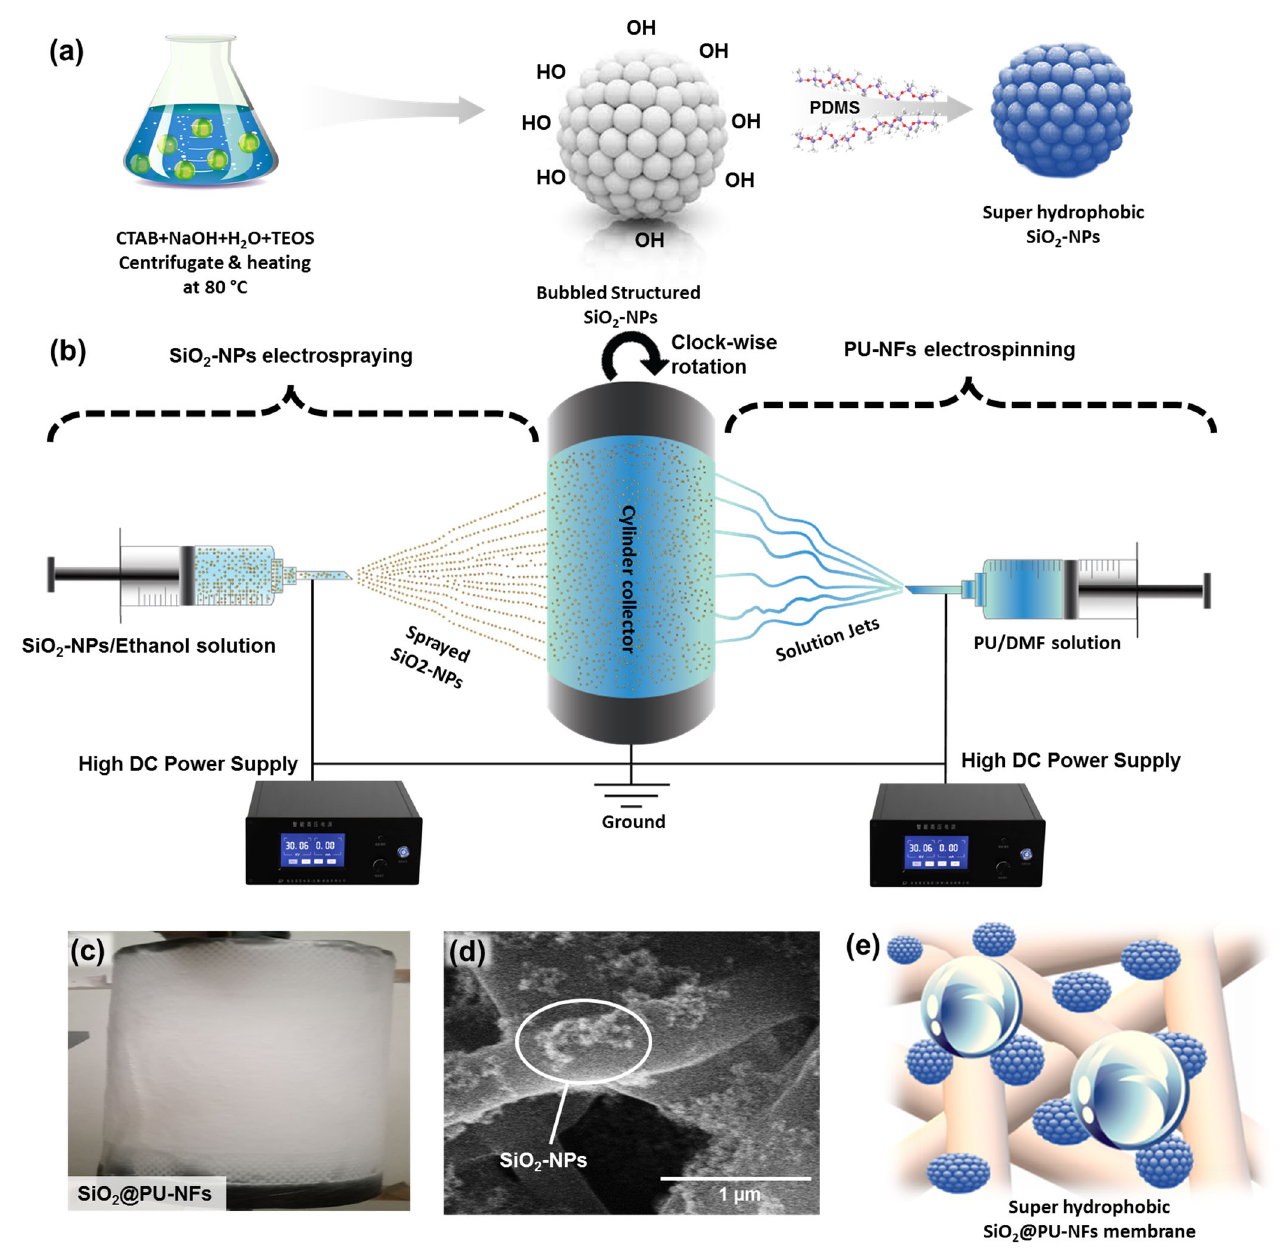
Figure 1. ( a ) Schematic representation of synthesis of bubble-structured SiO 2 -NPs and the chemical modi fi cation through PDMS; ( b ) schematic diagram of the simultaneous electrospraying and elec- trospinning arrangement; ( c , d ) photographic view and SEM images of composite SiO 2 @PU-NFs, re- spectively; ( e ) schematic illustration of water repellency of composite nano fi brous membrane.